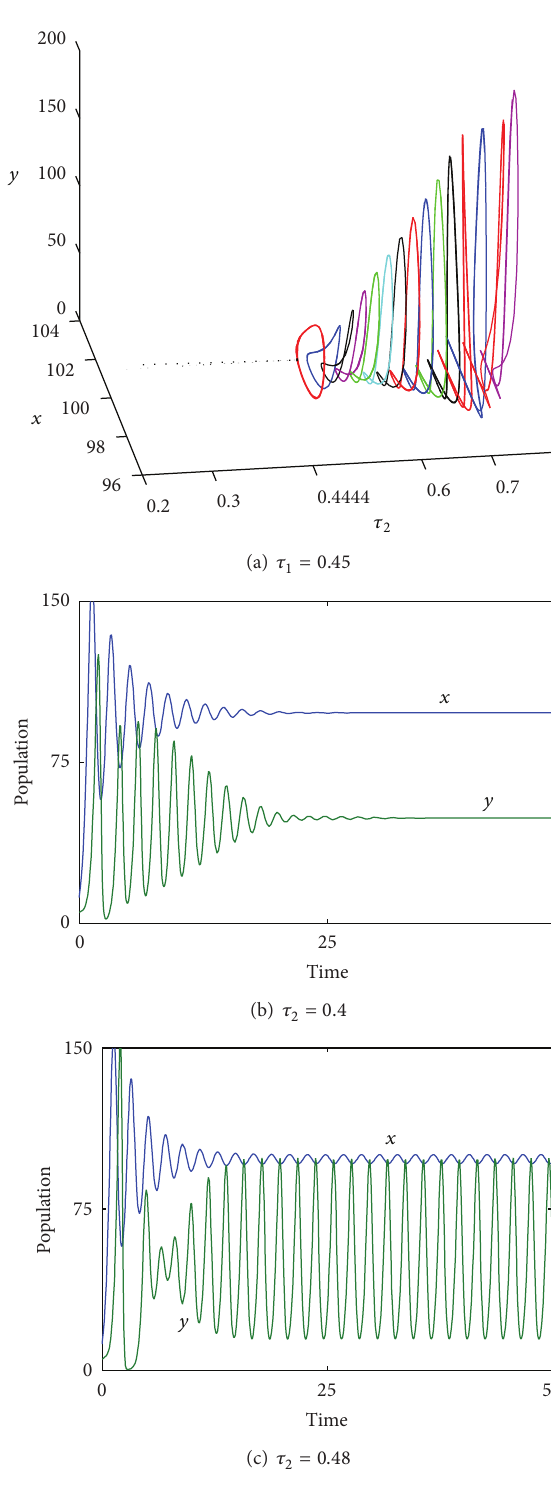
Figure 3: Bifurcation diagram of the system (3) with respect to 𝜏 2 Figure2:Bifurcationdiagramsofthesystem(3)withrespectto 𝜏 1 in in Case 3. (a) is drawn in the three-dimensional space (𝜏 2 ,𝑥,𝑦) . Case 2 in the three-dimensional space (𝜏 1 ,𝑥,𝑦) . (b) is the time series (b) and (c) are the time evolutions for 𝜏 2 = 0.4 < ̃𝜏 2 ) and (c) is the same for (𝜏 > ̃𝜏 ) . These figures show for (𝜏 1 < ̃𝜏 1 (system is stable) and 𝜏 2 = 0.48 > ̃𝜏 2 1 1 0 0 that the coexistence equilibrium is stable for 𝜏 1 < 0.5329 , unstable respectively. A Hopf bifurcation exists at 𝜏 2 = 0.4444 . Here, 𝜏 1 = 0.45 ∈ [0,0.5329) for 𝜏 1 > 0.5329 , and a Hopf bifurcation exists at 𝜏 1 = 0.5329 .